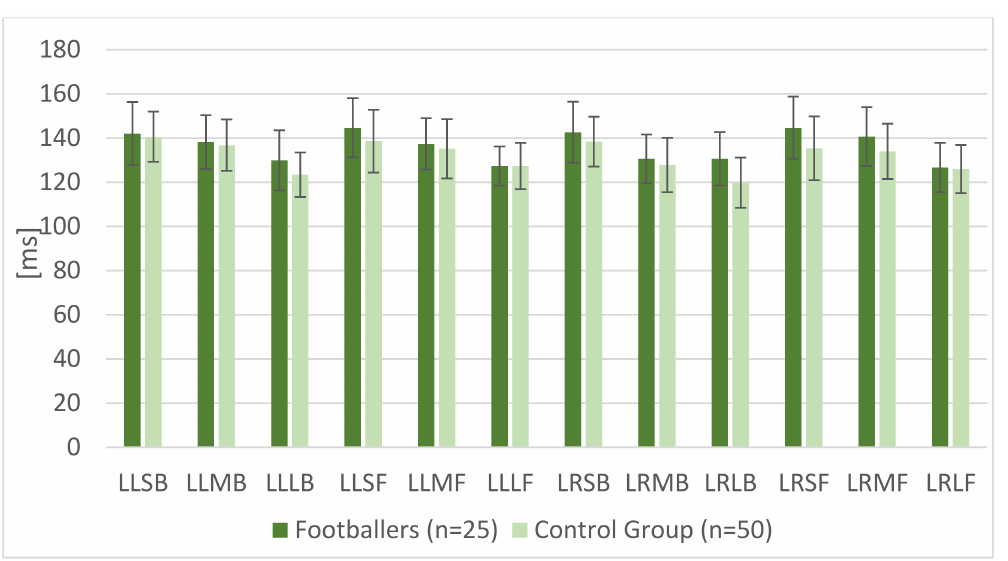
Figure 5. Motor Control Test—postural latencies for left (LL) and right (LR) lower limb for small, medium and large platform transitions in backward (SB, MB, LB) and forward (SF, MF, LF) direction for footballers and control group.